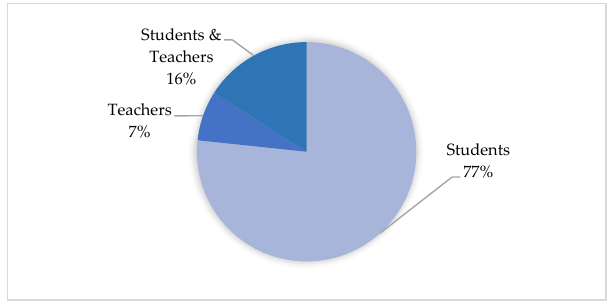
Figure 5. Actors from the selected studies.